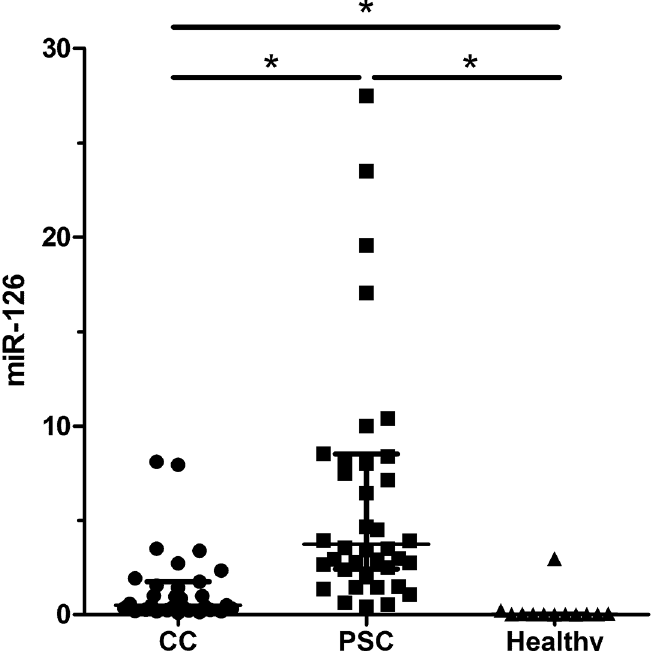
Fig 2. MiRNA analysis in serum. Serum validation analysis for patients with primary sclerosing cholangitis (PSC) (n = 40) and cholangiocarcinoma (CC) (n = 31) revealed differentially expressed miRNAs. Fig 2 shows the result for